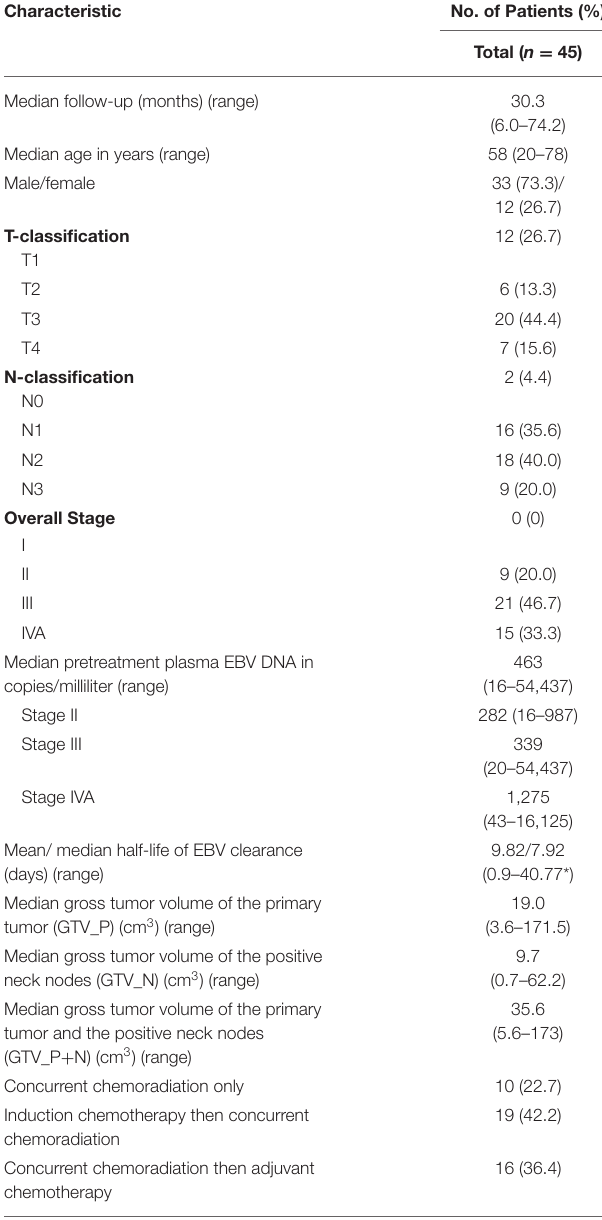
TABLE 1 | Patient baseline characteristics in the whole study population. Characteristic No. of Patients